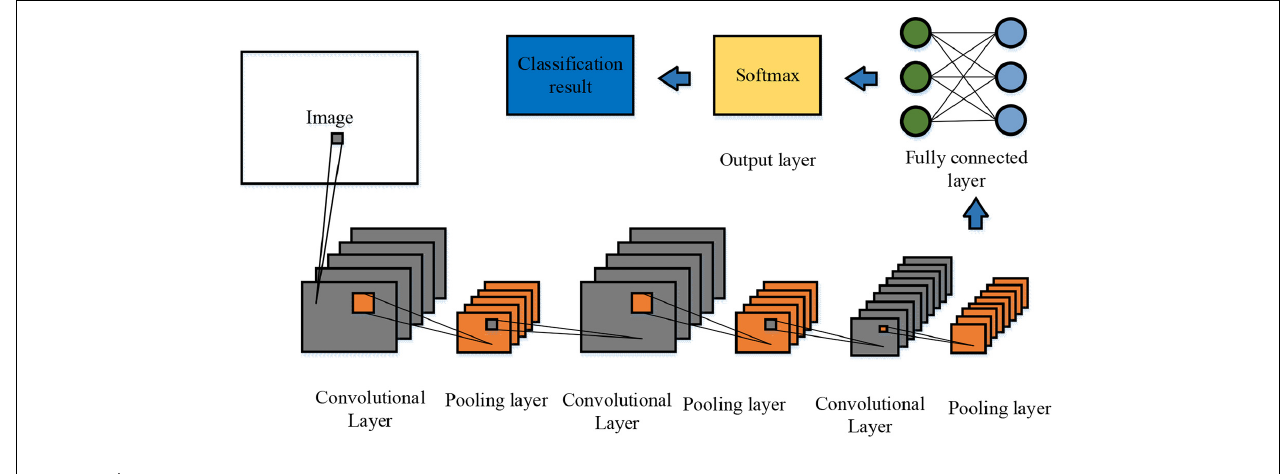
FIGURE 1 | Structure of the optimised C3D.